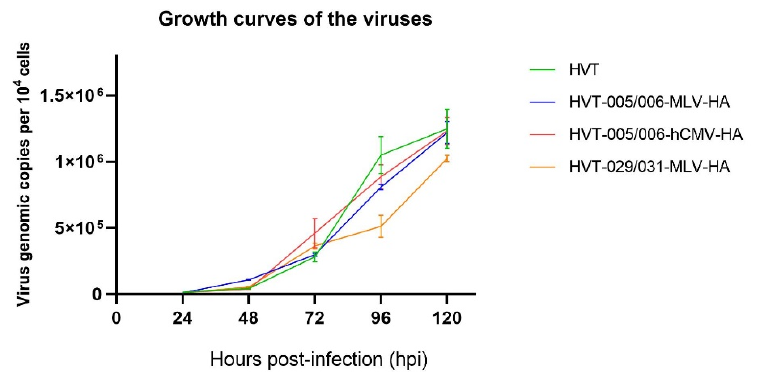
Figure 2. Growth curves of recombinant HVT viruses and HVT. Viral genomic copies per 10 4 cells, based on the HVT SORF1 gene, were determined by real-time qPCR on DNA from virus-infected CEFs sampled at 24, 48, 72, 96, and 120 h post infection. Differences between data for the parental HVT and the recombinant HVT viruses were analyzed by unpaired t -test and no significant difference was found ( p > 0.05).